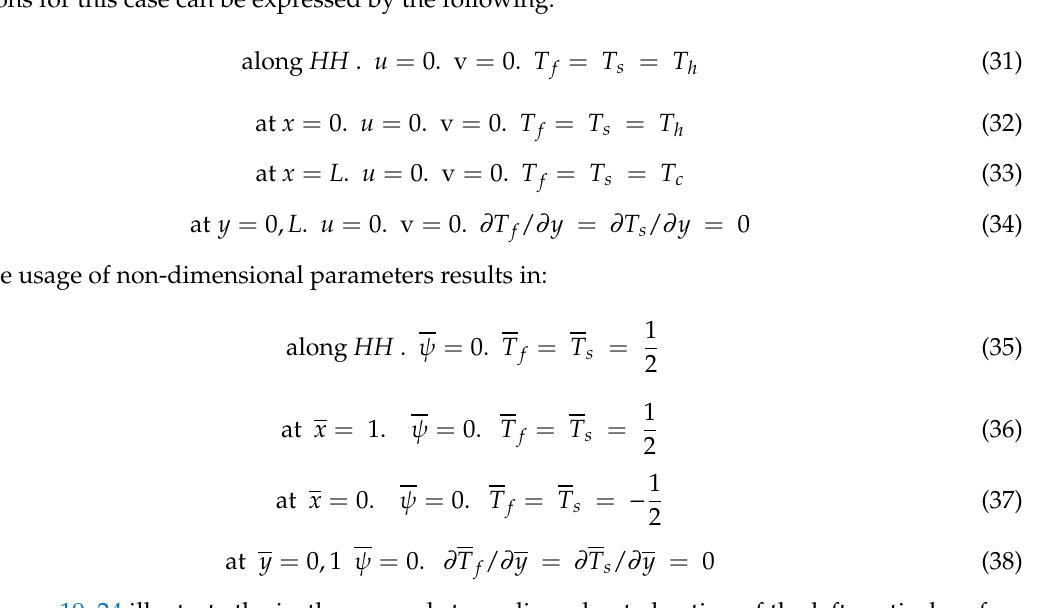
= x . Figure 18. Nusselt number at H